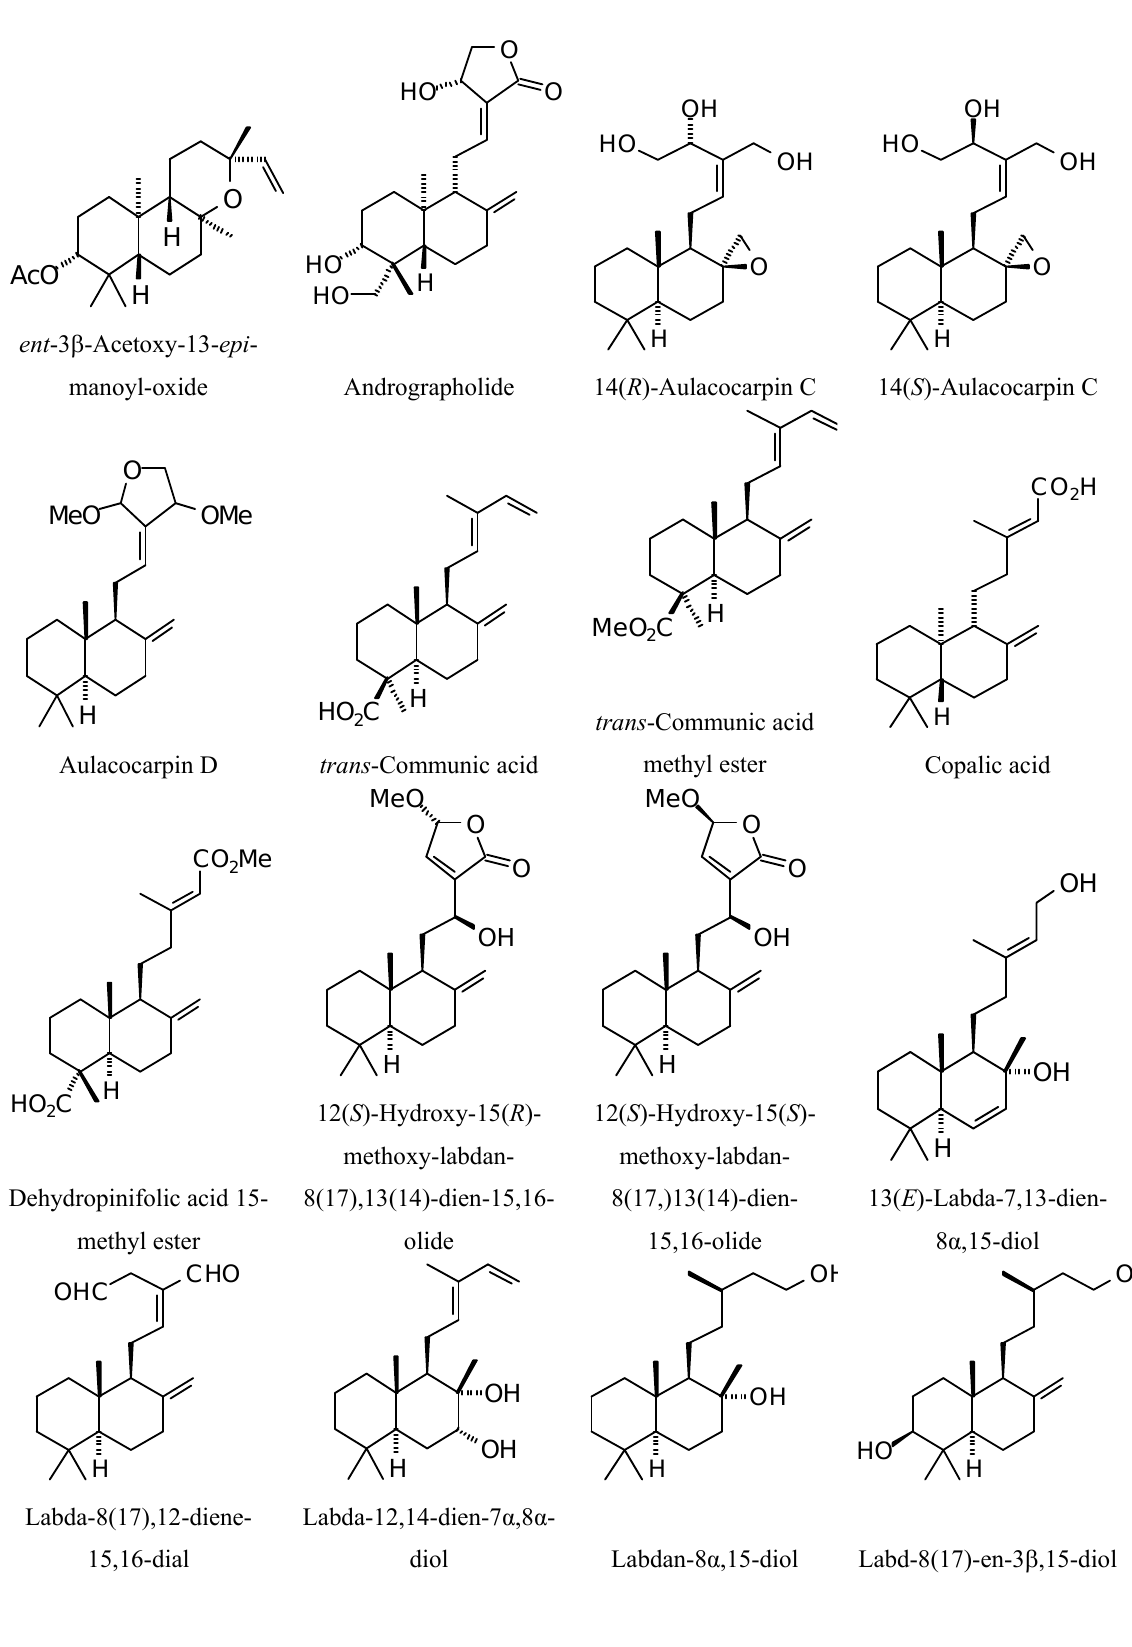
Figure 12. Labdane diterpenoids examined in this